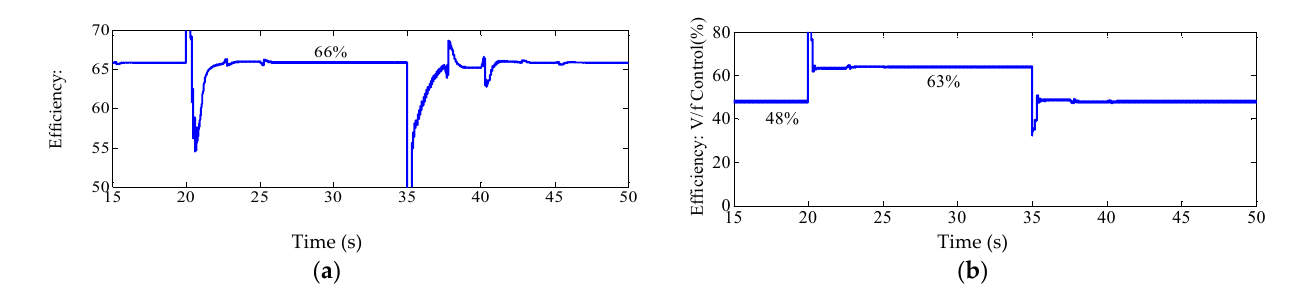
Figure 9. Comparison of the efficiency of proposed drive ( a ) with a regular v/f control drive ( b ) in the second scenario.